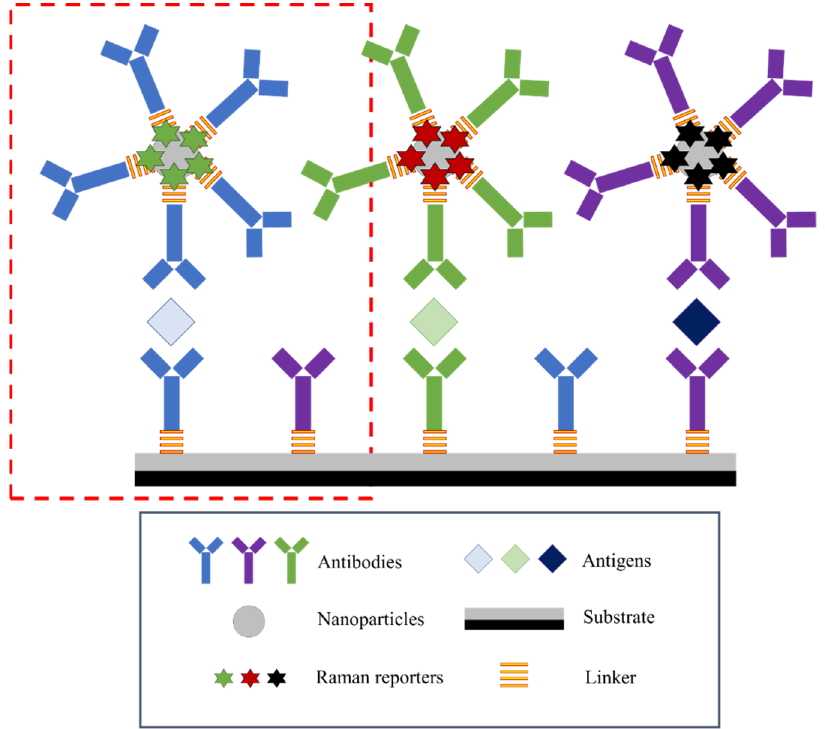
Figure 3. Schematic construction of the sandwich SERS immunosensor in the multiplexed version. The most frequently used approach enabling single-antigen analysis is shown in the red box.